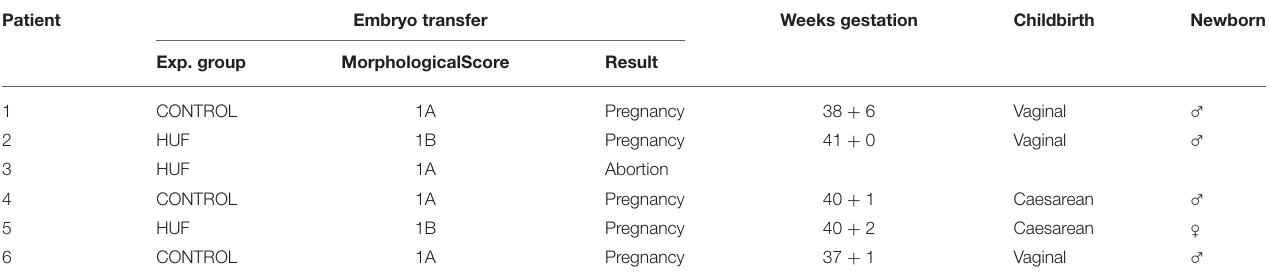
TABLE 4C | Clinical outcomes of embryo transfer to each receptor. Each embryo was blindly selected according to the porphological criteria described previously (Staicu et al., 2021).